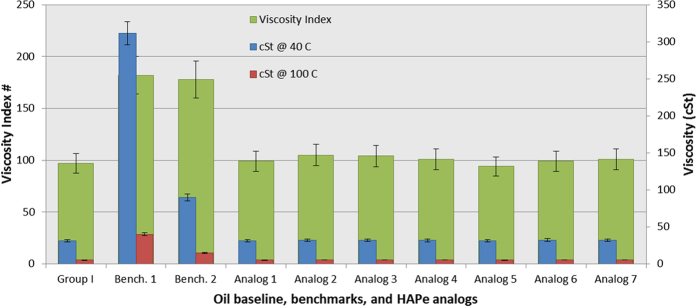
Viscosity data and index values as determined via a spindle viscometer.A standard 5% and 10% error was assigned to viscosity and viscosity index values, respectively.